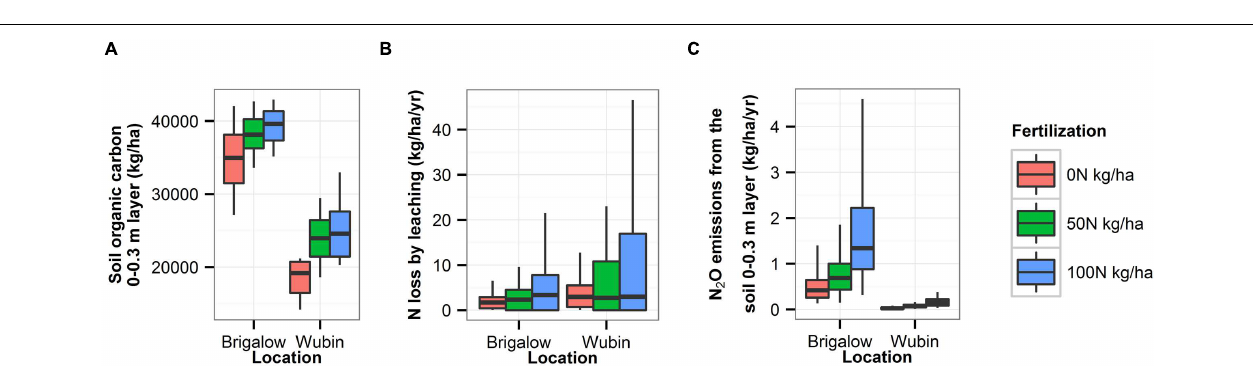
FIGURE 8 | Influence of the fertilization rate on SOC (0–0.3m) (A), N loss by leaching (B) and N 2 O emissions (C) for the combination of Brigalow soil plus climate and for the combination of Wubin soil plus